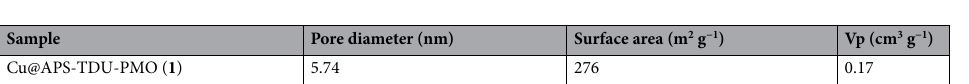
Table 1. Structural parameters of the Cu@APS-TDU-PMO ( 1 ) determined from N 2 adsorption–desorption experiment.